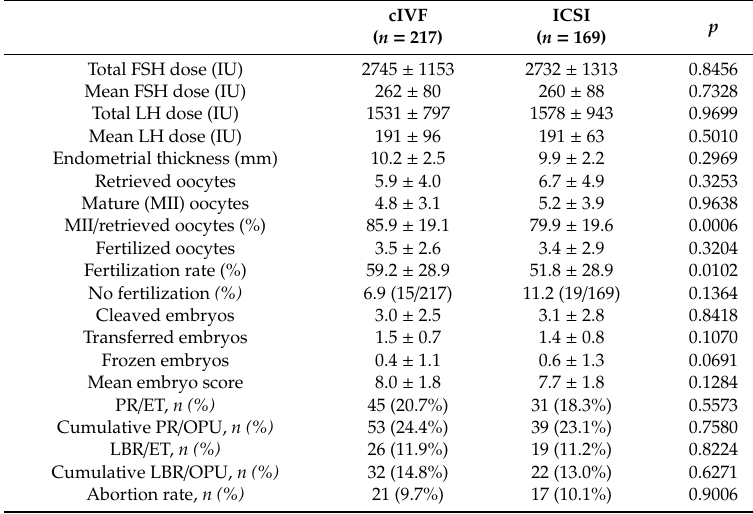
Cycle outcome in patients with no previous treatments in the two study groups (univariate analysis).